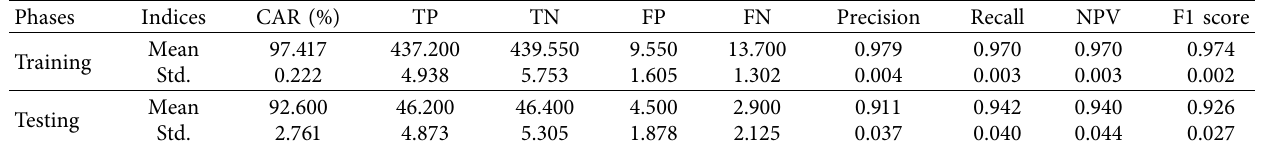
Figure 6: The L-SHADE optimization process. Table 2: Prediction performance of the L-SHADE-SVM-SVD.